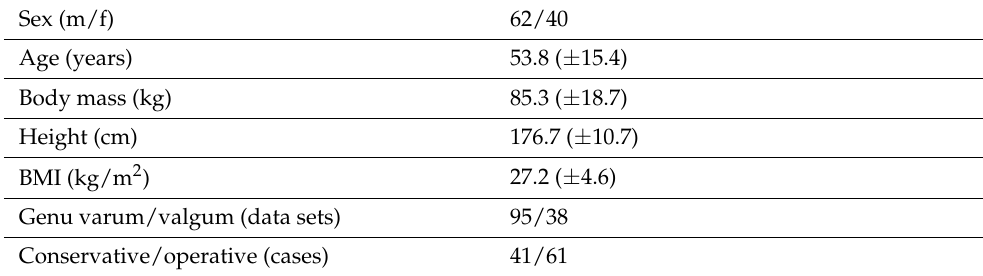
Table 1. Descriptive patient characteristics (N = 102, data sets =